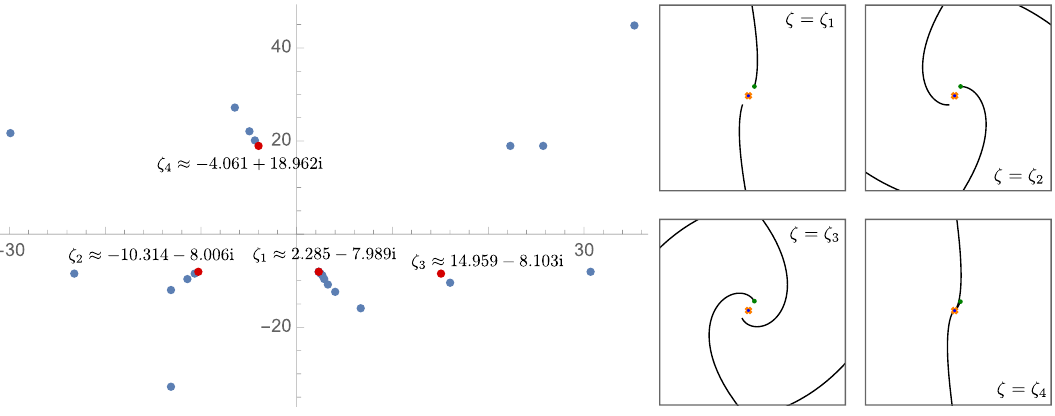
Figure 5 . Left: singularities of the Padé-Borel transform of Y (2) in (3.7) for u = 0 , m = − 1 / 10 , Λ = 1 and z = e i , with N = 40 terms in the series. The leading singularities ζ match well with (3.23); thus as expected they are the central charges of BPS solitons on the surface defect with parameter z . (For Y (1) the singularities would be at the opposite points ζ = − ζ Right: for fixed ζ = ζ we plot a cutoff version of the Stokes graphs with ϑ = arg( ζ ) , plotting i the Stokes curves only up to | 2 R z λ | = | ζ | . As explained around (3.23), the cutoff Stokes curves z 0 W ϑ =arg( ζ i ) run exactly up to the point z = e i , which is plotted as a green dot.